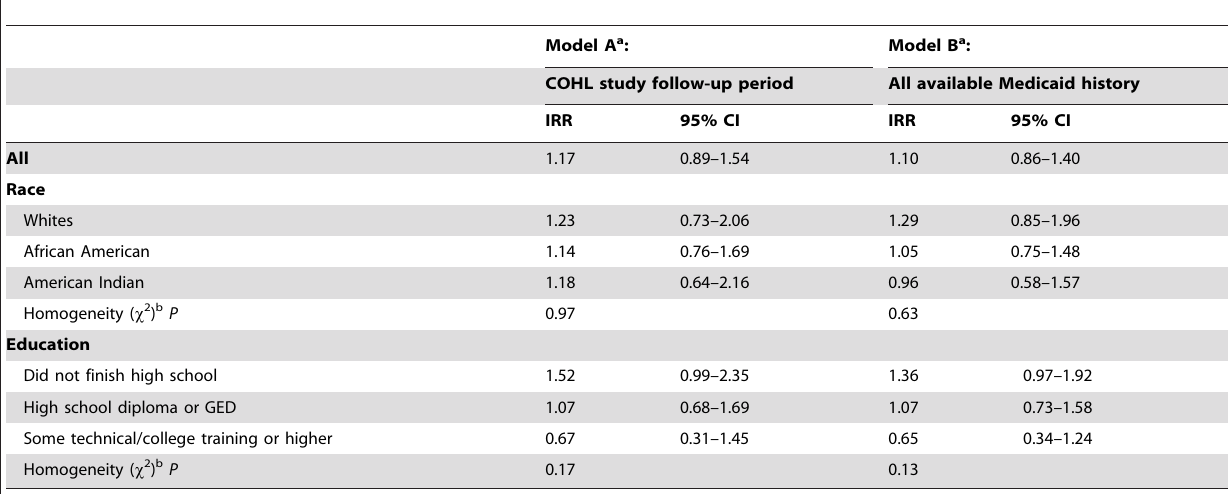
Table 4. Estimates of the Association between Caregivers’ Low Health Literacy (Defined as NVS Score of less than 2) and the Incidence of Children’s Medicaid Enrollment Gaps, Overall and Stratified by Educational Attainment, among the COHL Study Follow-up Cohort in North Carolina, during the Study Period (A) and Using all Available Medicaid History (B) between January 2004 and December